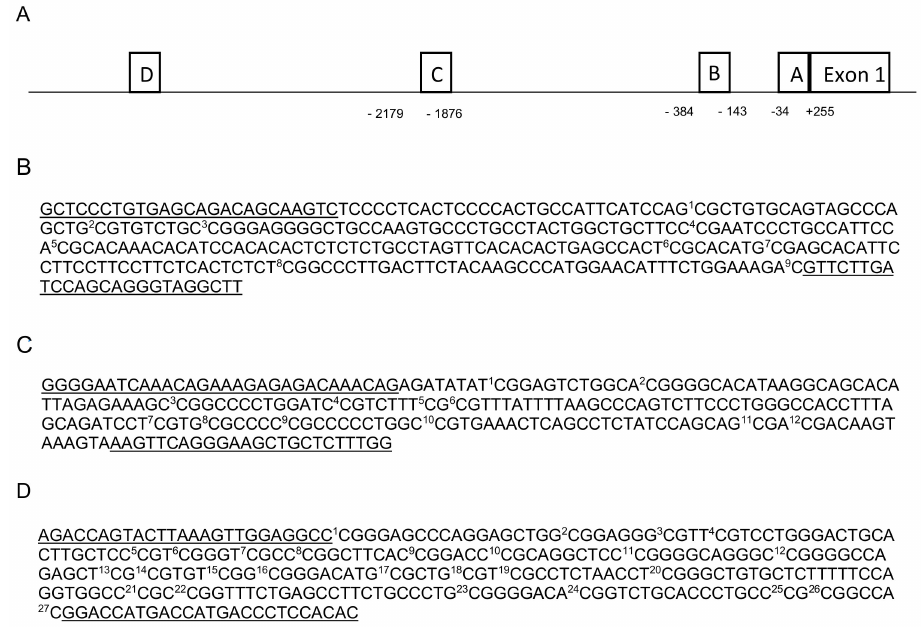
Figure 2. ( A ) Schematic figure of ESR1 promoter region. ( B ) Assessed DNA sequence ( − 2179; − 876) in CpGI shore near promoter C, including nine CpGs. Methylation at CpGs 1–9 was associated with E2 deprivation in humans [44]. Altered methylation at these CpGs region was associated with ovariectomy and age in the hippocampus of female rats [32]. ( C ) Assessed DNA sequence ( − 384; − 143) in promoter B, including 12 CpGs located in a CpGI. ( D ) Assessed DNA sequence in Promoter A ( − 34; + 255), including 27 CpGs located in a CpGI. Underlined sequences correspond to the primers